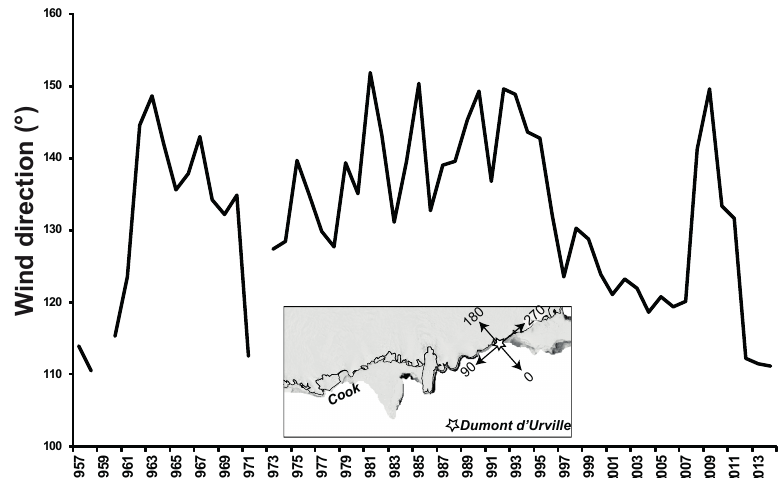
Figure 10. Mean annual wind direction from Dumont d’Urville research station during